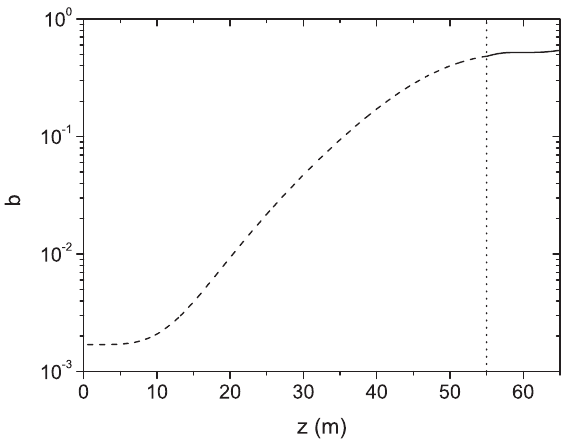
FIG. 4. Evolution of the ensemble-averaged rms bunching factor along the planar undulator SASE3 (dashed) and the helical afterburner (solid).